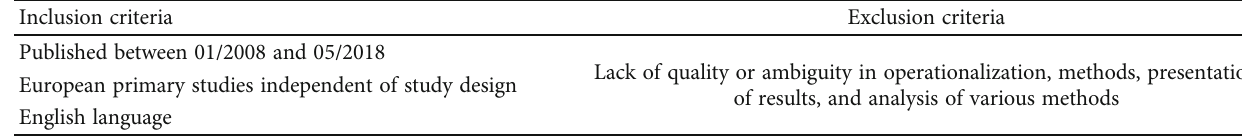
Table 1: Inclusion and exclusion